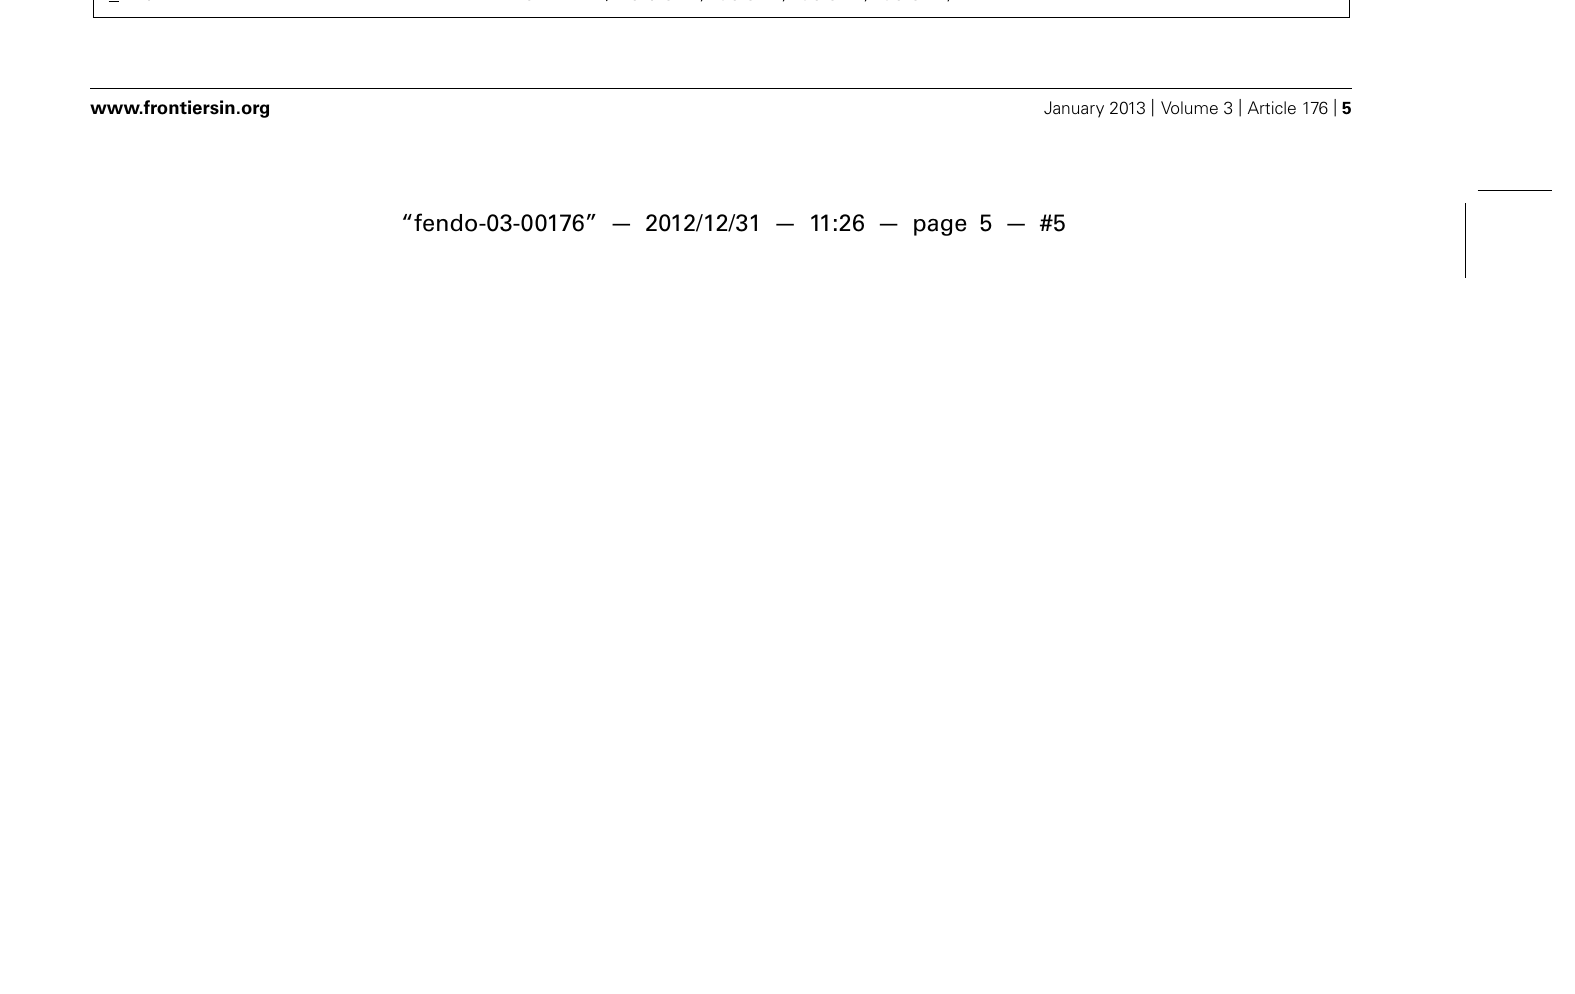
FIGURE 5 | Germ cell development in the first week postnatally in the rat, showing the germ cells labeled with MVH (mouse homolog of Drosophila Vasa), and the Sertoli cells labeled with MIS/AMH (bar = 10 μ m). (A) Day 0, (B) Day 4, (C) Day 6, (D) Day